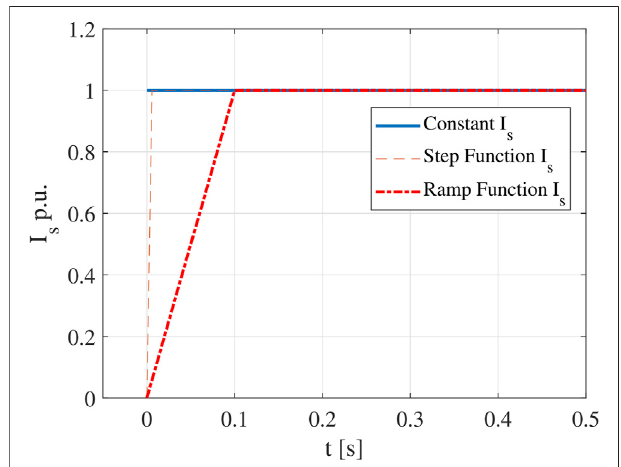
FIGURE 1 | I s waveform of the three methods (analytical